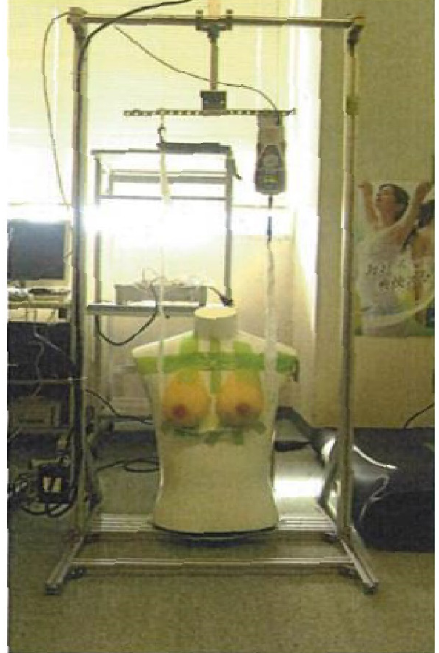
Figure 3. Prototype